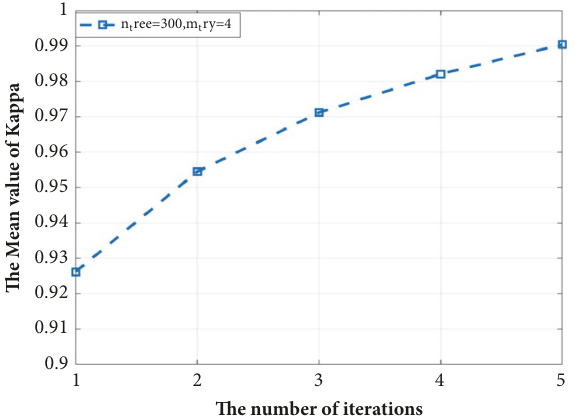
Figure32:Classificationkappatrendofdifferentinitialanditerative condition of Hyperion data for method